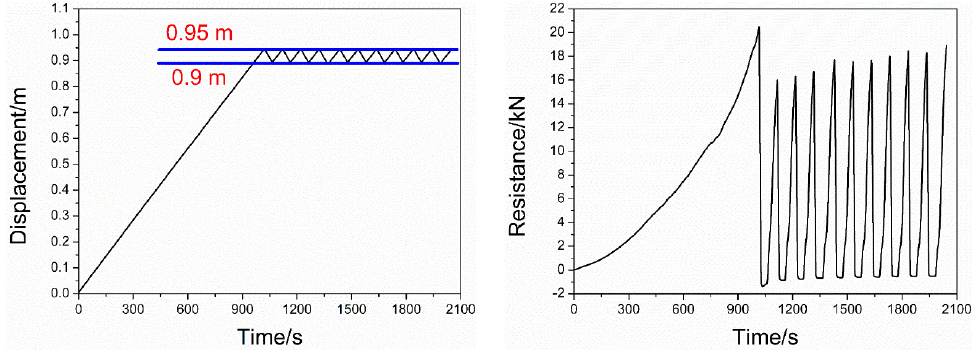
Figure 17. Displacement and resistance of the pressure-pull-out loading method.